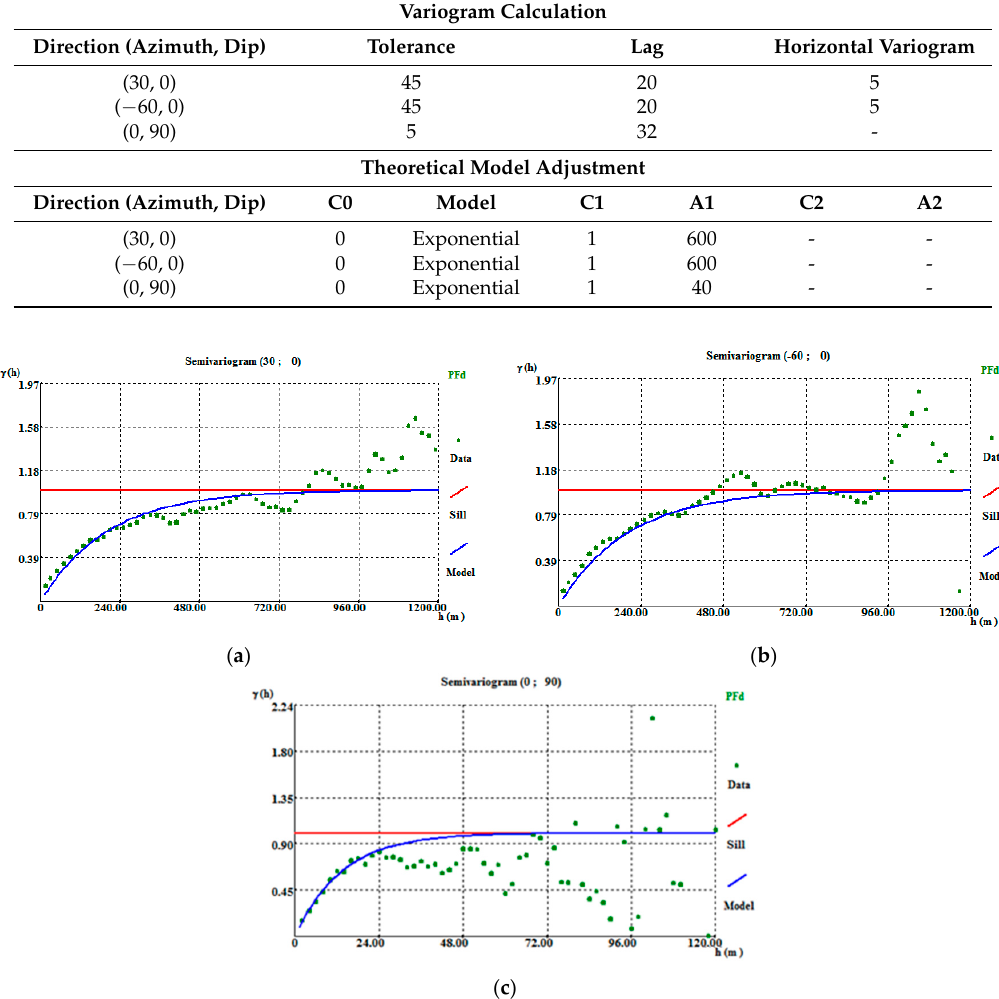
Figure A7. Borehole VP directional variograms: ( a ) horizontal variogram; ( b ) vertical variogram. The regularization was performed on a 50 m × 50 m × 30 m grid. Table A8. Calculation and adjustment parameters for stope VP variograms. Table A8. Calculation and adjustment parameters for stope VP variograms.